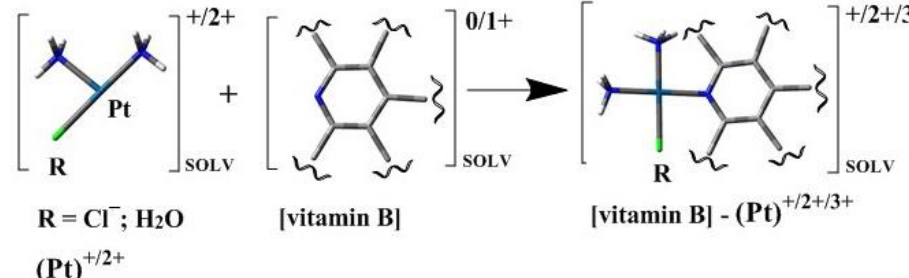
Figure 5. Scheme of complexes of B vitamins with Pt-mono and Pt-diaqua complexes.